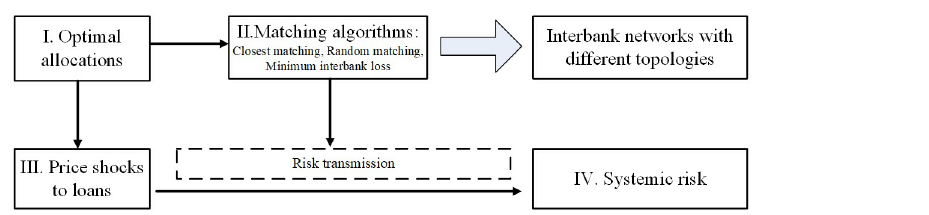
Fig 3. Overview of the banking network model.